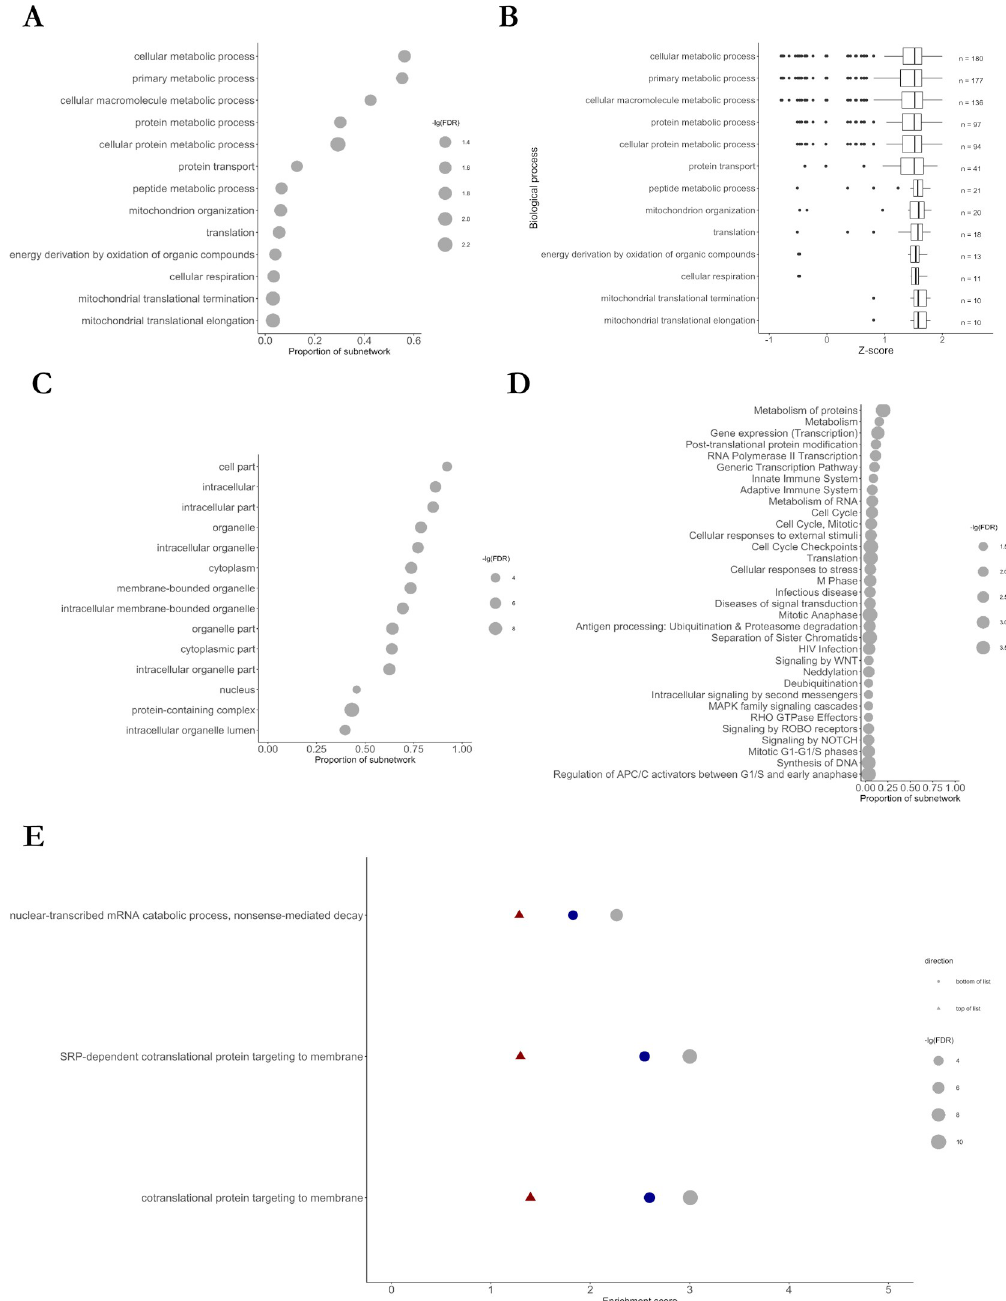
Fig 3. Enrichment analysis of M1 subnetwork. A: Gene ontology (GO) term enrichment analysis for biological processes. B: Mean Z-ratios of genes belonging to the enriched biological processes. C: Gene ontology (GO) term enrichment analysis for cellular compartments. D: Enrichment of Reactome pathways. The size of the circles depicts the negative decadic logarithm of the false-discovery rate (FDR). E: Result of gene set enrichment analysis against the gene ontology database. Only gene sets identified in each dataset (red: GSE33000; blue: GSE129473; grey: GSE64810) are shown and sets were ordered according to the score of the RRA analysis.